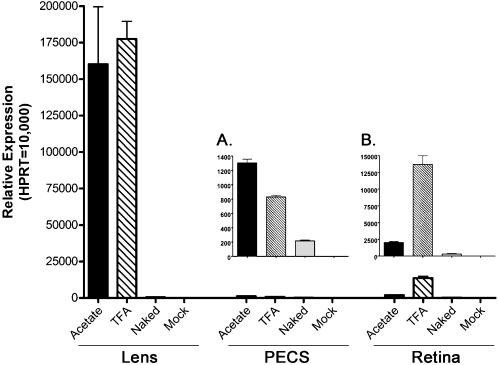
Ocular expression levels of EGFP mRNA after intravitreal injection.At 2 days post-intravitreal injection of 0.6 µg of compacted DNA, the lens, pigment epithelium/choroid/sclera (PECS), and retina were isolated.qRT-PCR was used to assess EGFP mRNA levels and normalized to the neuronal housekeeping gene HPRT.Both the AC-GFP and TFA-GFP nanoparticles produced substantial expression of EGFP in the lens as compared to the naked plasmid control.In the PECS (A) and retina (B), both nanoparticles produced EGFP mRNA at levels several fold higher than naked plasmid.No expression of EGFP was detected in any of the mock-injected samples.